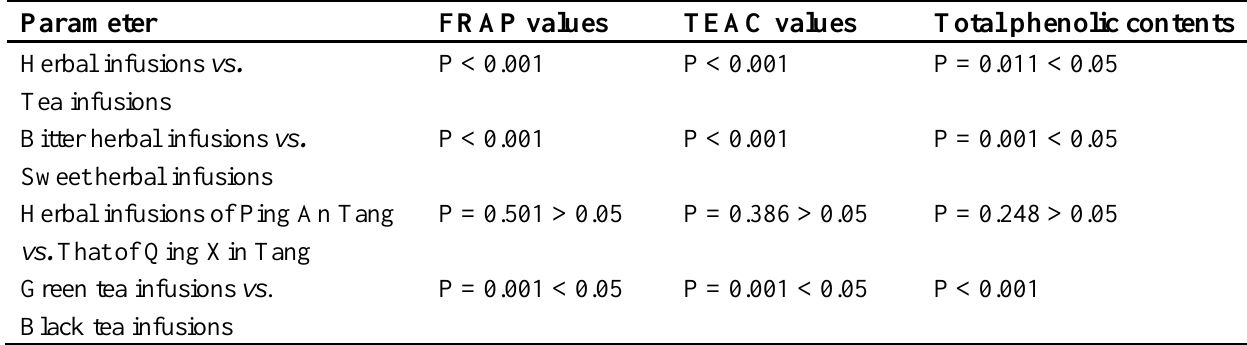
Table 4. Comparison of different